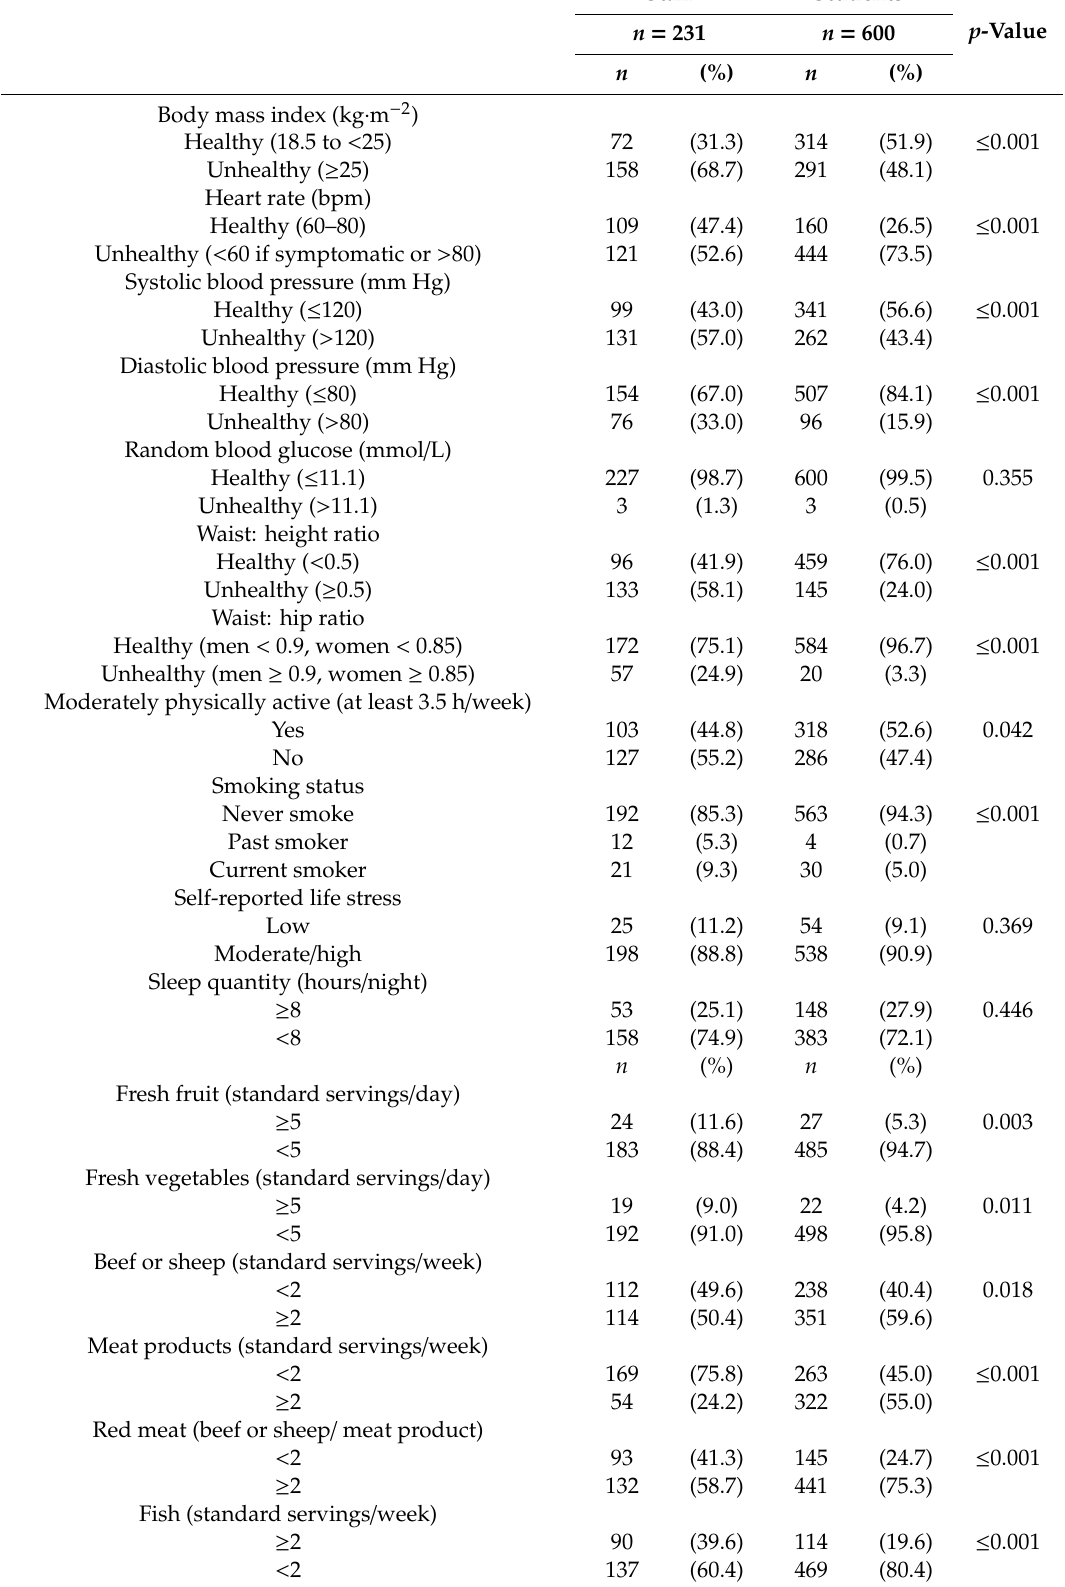
Table 2. Objective and behavioral characteristics of sta ff vs.